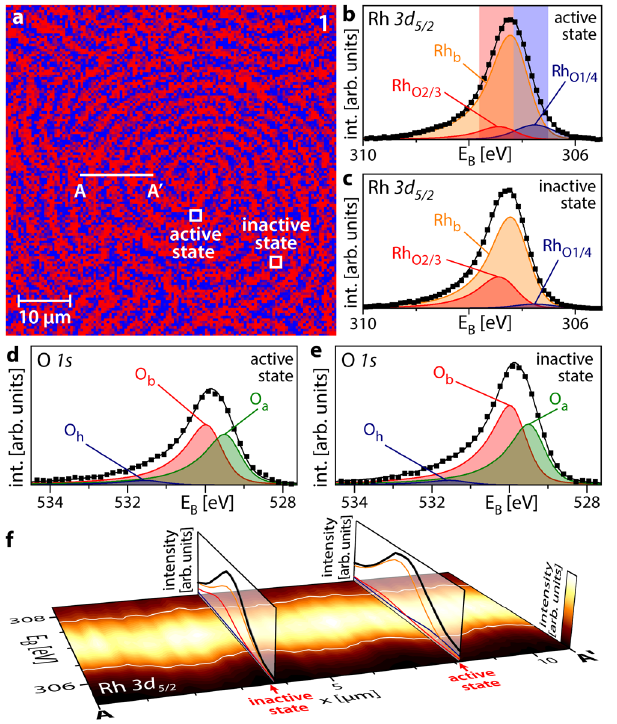
Fig. 2 Oscillating pattern in H 2 oxidation on Rh (T = 453 K, p O2 = 1.1 × 10 − 6 mbar, p H2 = 1.2 × 10 − 6 mbar). a Rh 3d 5/2 SPEM map of region 1 in Fig. 1a showing the distribution of 2/3 (red) and 1/4 (blue) oxygen-bound Rh states on the Rh(17 10 2) domain; b Rh 3d 5/2 XPS spectrum corresponding to the catalytically active state. Rh b : bulk Rh; Rh O2/ 3 and Rh O1/4 correspond to Rh bound to oxygen; further details are given in the text. Squares: measured values; black solid line: sum of the deconvoluted components. The energy windows for constructing the SPEM map are shaded red and blue; c the same as in ( b ) but for the catalytically inactive state; d O 1 s XPS spectrum corresponding to the catalytically active state. O a and O b are associated with adsorbed atomic oxygen species, while O h corresponds to the OH reaction intermediate. Squares: measured values; black solid line: sum of the deconvoluted components; e the same as in ( d ) but for the catalytically inactive state; f XPS spectral line pro fi le along the line A-A ′ marked in ( a ), with the colour code shown at the right edge. Vertical slices show exemplary spectra for the catalytically inactive and active states. The oscillating white lines serve as a guide for the eye. refer to the number of O atoms each Rh surface atom is bound to and the number of Rh surface atoms each O atom is bound to, respectively. The deconvolution procedure and notation are based on previous studies, reporting the Rh 3d 5/2 spectral components characteristic for adsorption of oxygen on different Rh single crystal surfaces 23 – 26 .